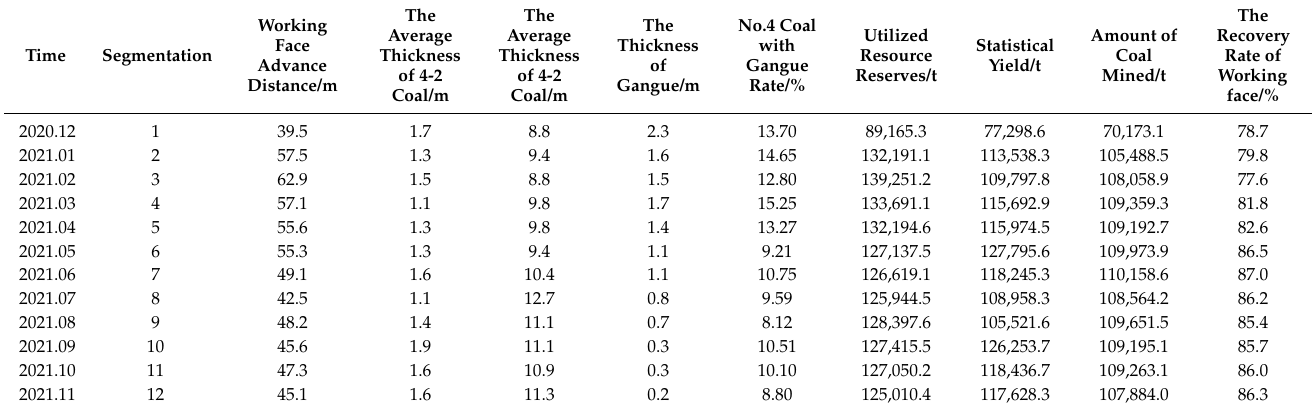
Table 3. Working face 42,108 recovery rate